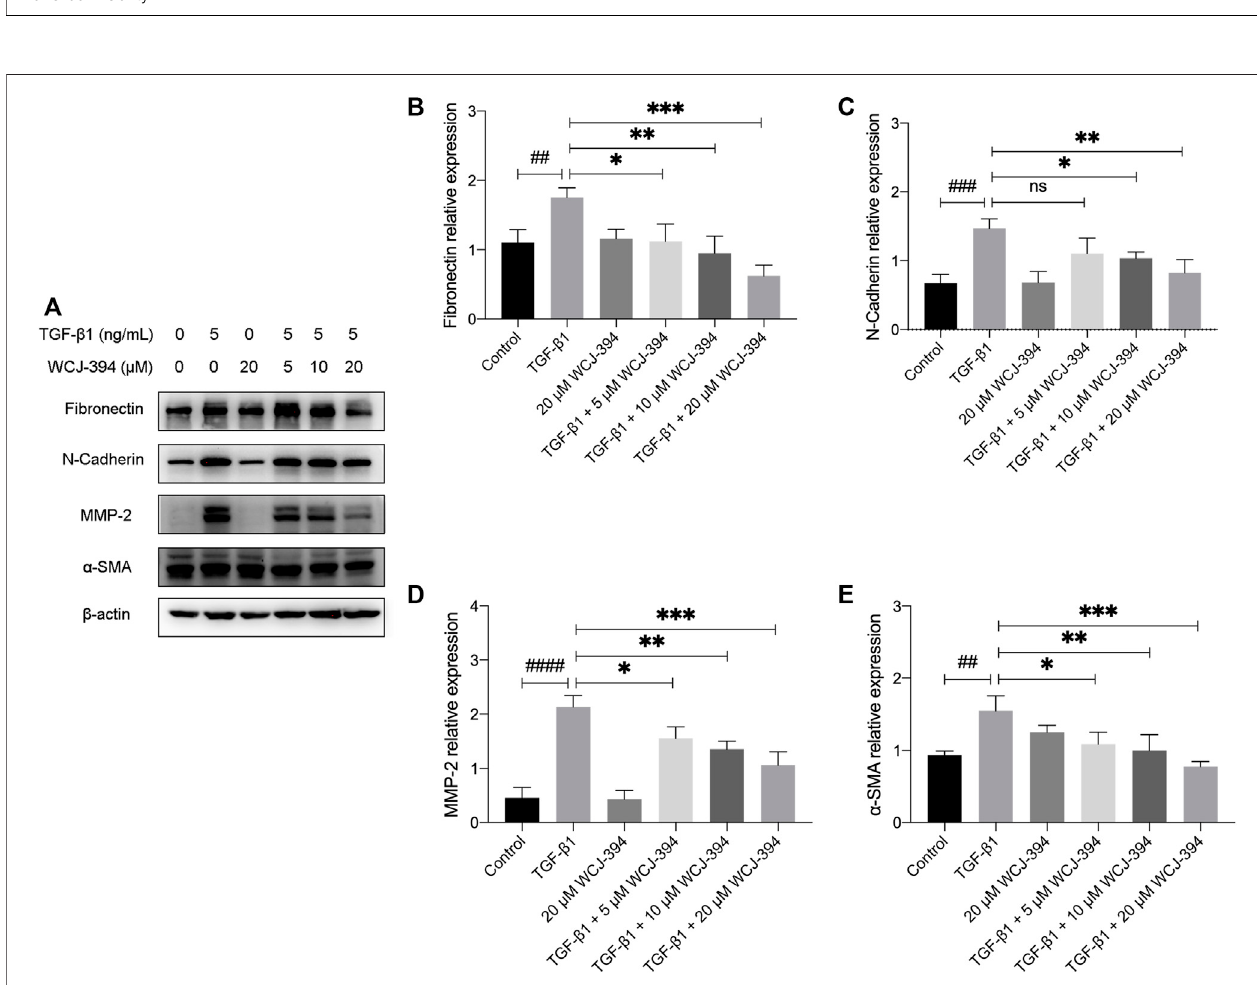
FIGURE 5 | WCJ-394 repressed the expression of TGF- β 1-induced mesenchymal markers in A549 cells. (A) The in fl uences on fi bronectin, N-cadherin, MMP-2, and α -SMA( α -smooth muscleactin)inA549cellswhentreated withTGF- β 1(48 h)alone orincombinationwithWCJ-394(5, 10,and 20 μ M). (B – E) Expression levelsof fi bronectin, N-cadherin, MMP-2, and α -SMA relative to the internal control β -actin. ## p < 0.01, ### p < 0.001, #### p < 0.0001 vs. the control group; * p < 0.05, ** p < 0.01, *** p < 0.001 vs. the TGF- β 1 group.